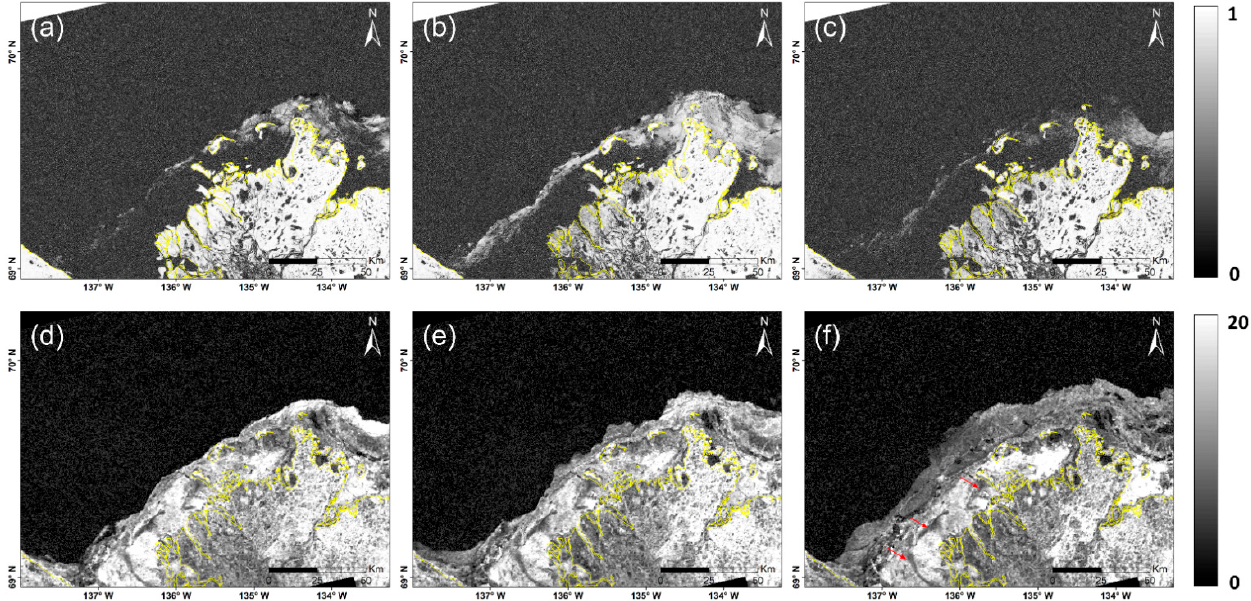
Figure 4. Comparison between InSAR coherence ( a : 20180113–20180125, b : 20180125–20180206, c : 20180206–20180302) and SNR ( d : 20180113–20180125, e : 20180125–20180206, f : 20180206–20180302). InSAR coherence was processed with a 5 by 5 window for multilooked data (16 by 4 pixels in range and azimuth) and the adaptive filter was applied with a Fast Fourier Transform (FFT) window of 32. The red arrows in Figure 4f indicate relatively low SNR in the inner floating landfast ice for comparison with Figure 9d. The coastline is shown in yellow.